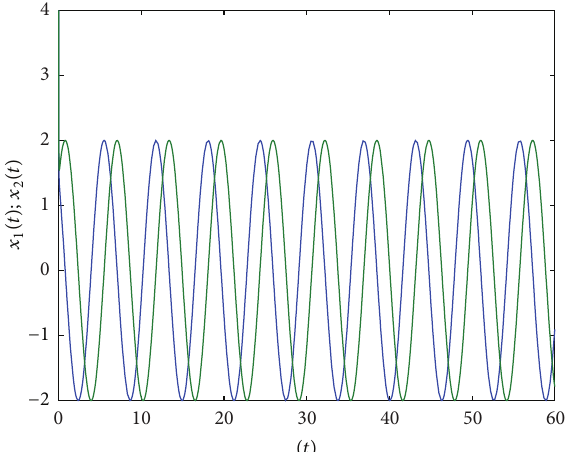
Figure 2: 𝑥 1 (𝑡) and 𝑥 2 (𝑡) of the nonlinear system (1a) and (1b), with 𝑎 = 𝑐 2 = 𝑘 = 𝑖 = 1, 𝑐 1 = 2, 𝑟 = 4, 𝑑 = 0.1, [𝑥 10 𝑥 20 ] 𝑇 = [4 4] 𝑇 .